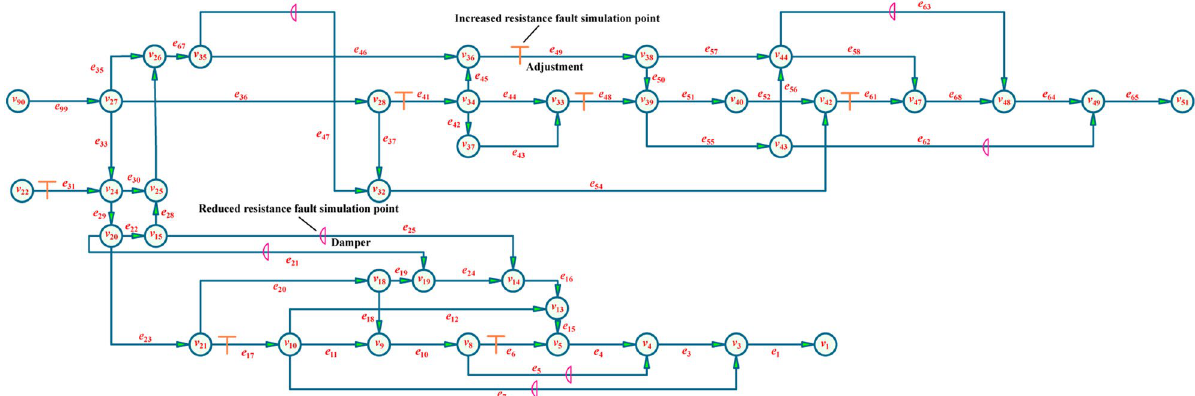
Figure 7. Experimental system